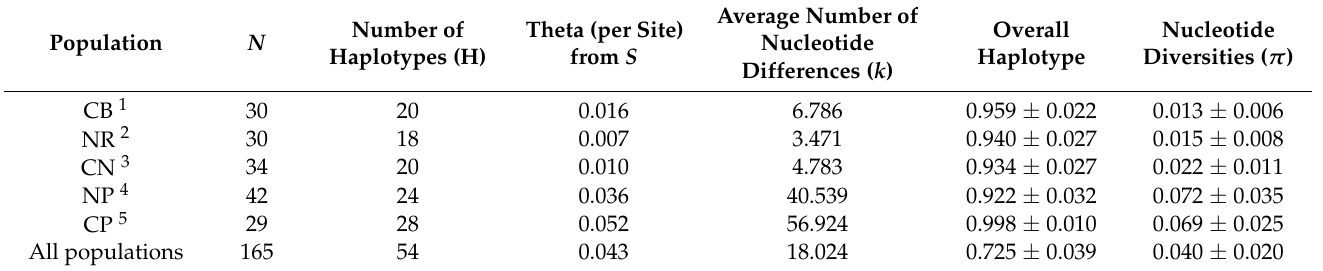
Table 5. Mitochondrial DNA D-loop sequence diversity of Siamese ( Crocodylus siamensis , Schneider, 1801) [1] and saltwater crocodiles ( Crocodylus porosus , Schneider, 1801) [13].